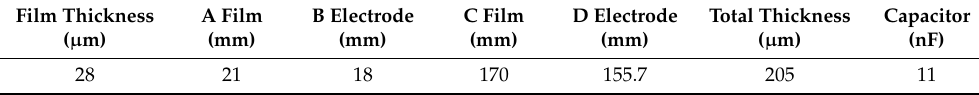
Table 1. Dimensions of a piezo film (LDT4-028K/L)